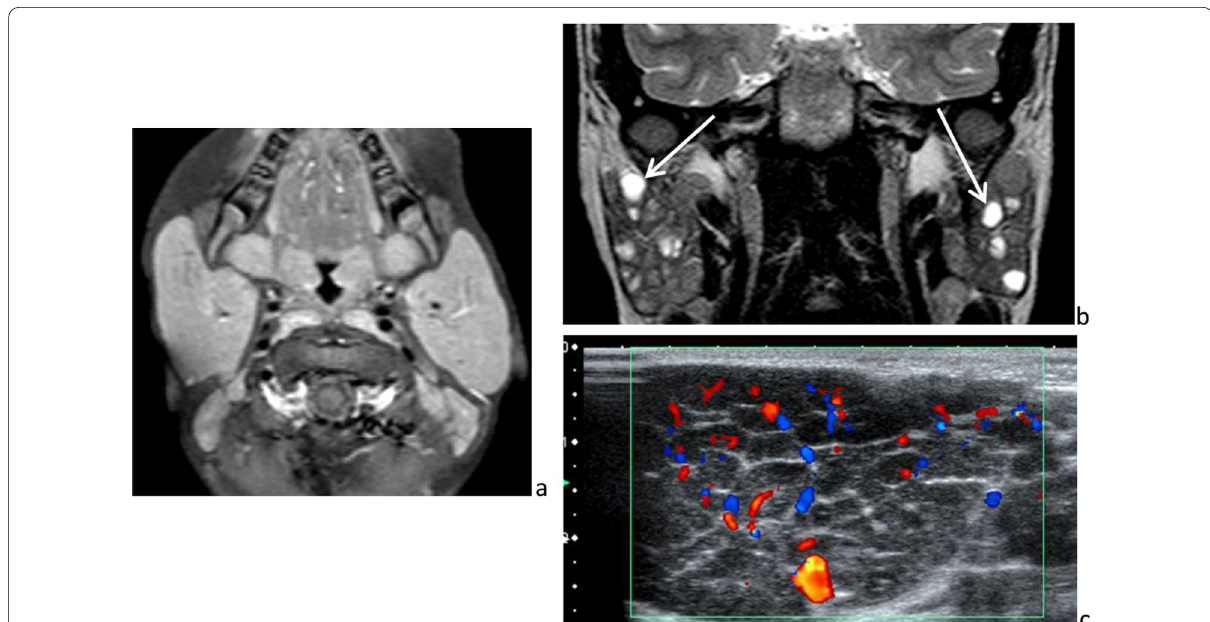
Fig. 4 HIV‑related disorders in 3 different patients. Diffuse homogeneous parotid enlargement on axial T 1 ‑weighted image, after intravenous administration of gadolinium chelate ( a ), lympho‑epithelial cysts on frontal T 2 ‑weighted image ( b ) and benign lympho‑epithelial lesions, hypoechoic on ultrasonography ( c )